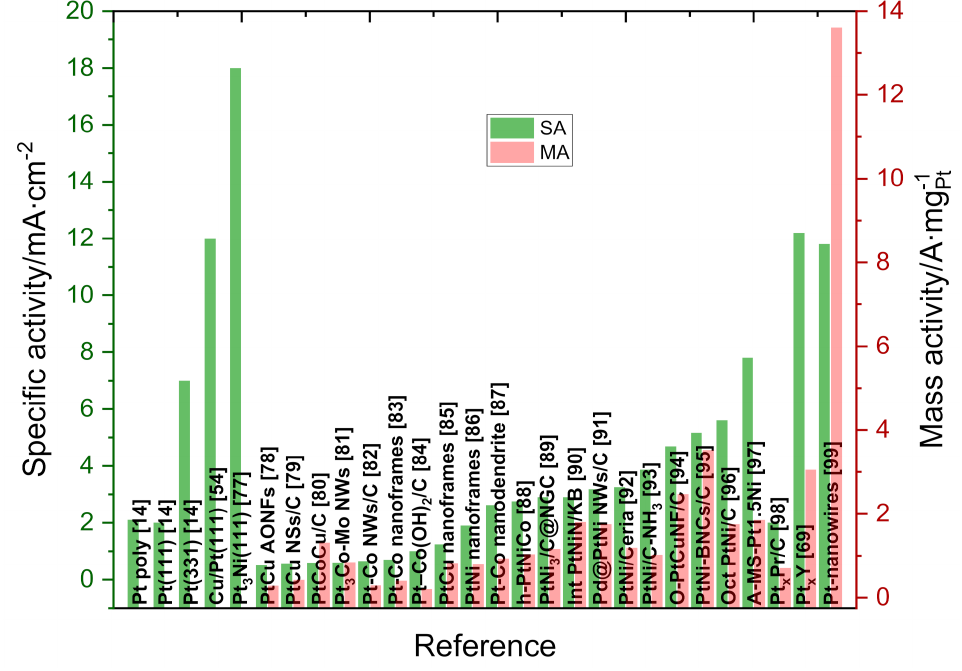
Figure 1. Specific and mass activity of selected bi- and tri-metallic Pt-alloys for ORR in 0.1 M HClO 4 . Results obtained on Pt poly, Pt(111), Pt(331), Cu/Pt(111), and Pt 3 Ni(111) are shown as a reference for the specific activity, whereas Pt x Y, one of the highest SAs reported among lanthanide alloys and Pt-nanowires, displayed the highest MA to